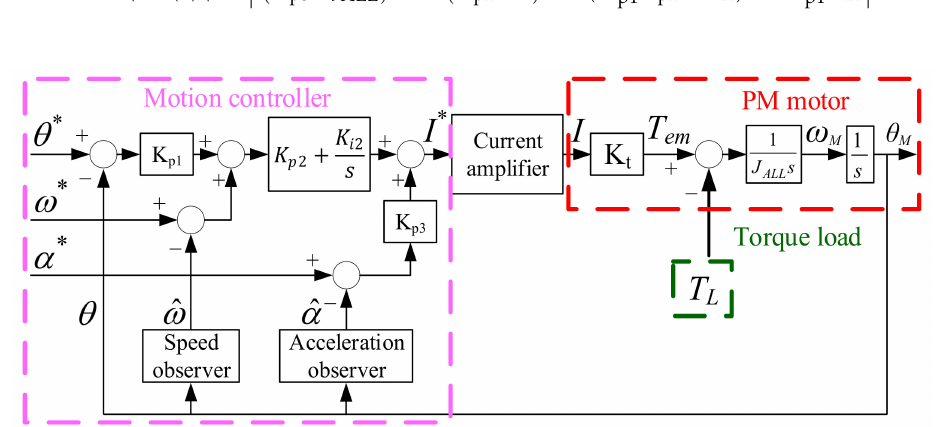
Figure 13. Advanced PM motor motion control with proposed acceleration control to improve the disturbance rejection at high